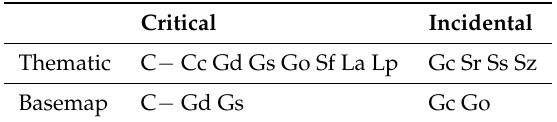
Figure 1. H. C. Beck’s London subway “Tube” map design, as originally published in 1933. This design differed significantly from previous designs in that it introduced a schematized (i.e., heavily generalized) geometry, rather than present the Tube rail lines with planimetric accuracy. Table 2. Schedule of operators for Beck’s London Underground